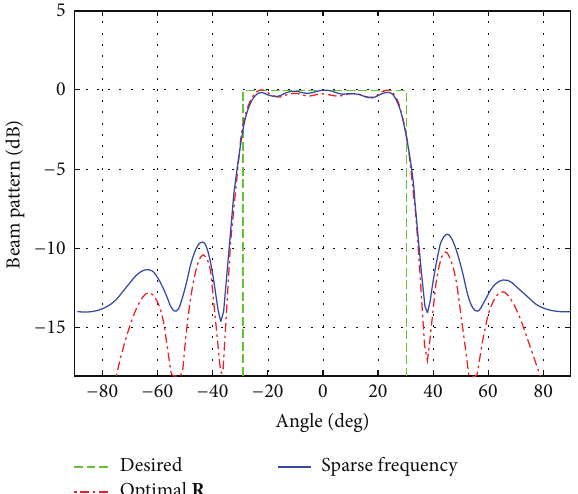
Figure 6: Beam pattern of sparse frequency waveforms and desired beam pattern and beam pattern of optimal covariance matrix R